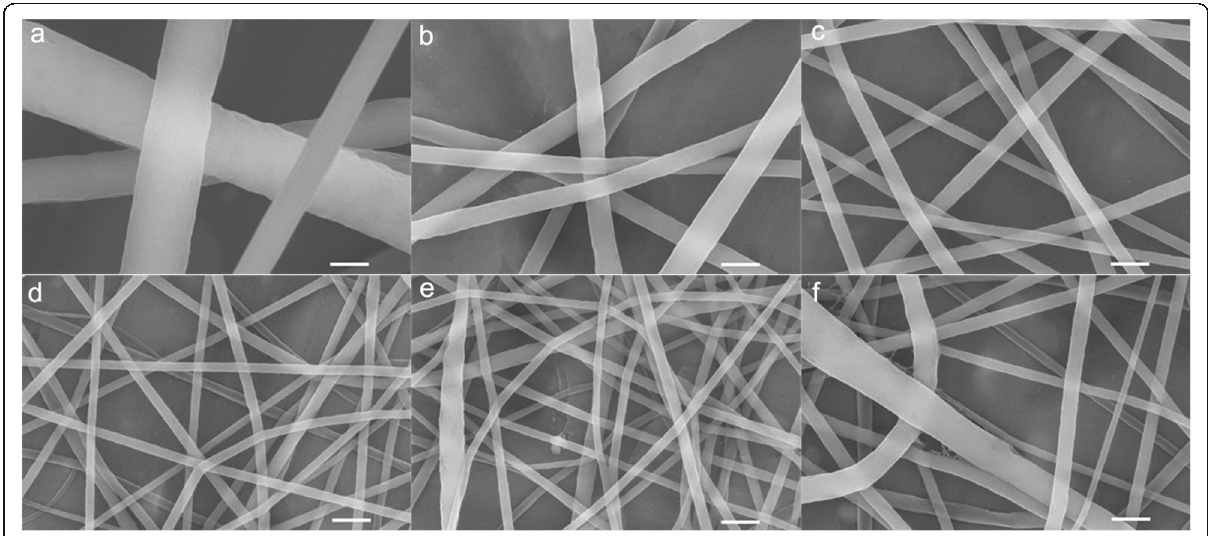
Fig. 4 The morphology of PVDF-HFP nanofiber under different voltage value a 6 kV, b 10 kV, c 15 kV, d 20 kV, e 25 kV, and f 30 kV (the scale bar is 600